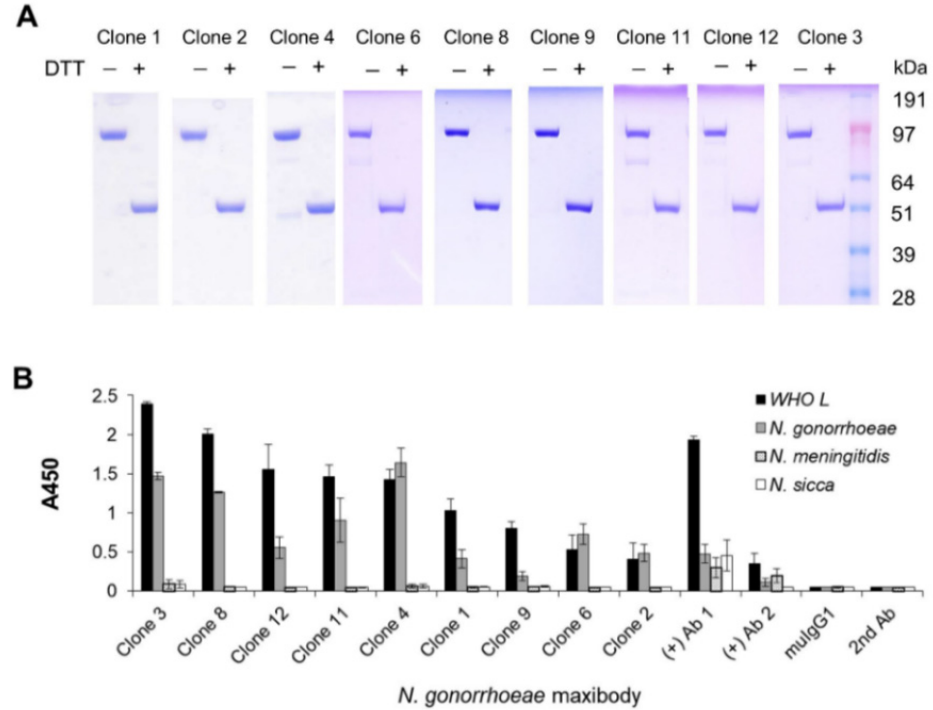
Figure 3. Generation and binding of anti- N. gonorrhoeae maxibody. ( A ) Purified maxibodies were resolved on 4–12% ( w / v ) bis-Tris SDS-PAGE under non-reducing ( − DTT) and reducing (+DTT) ( B ) Analysis of monoclonal maxibody specificity of N. gonorrhoeae and WHO L reference strain . Commercially available anti- N. gonorrhoeae antibodies (Ab1 and Ab2) were used for comparison. Irrelevant mouse isotype control was included as the negative control antibody. Maxibodies Ab1